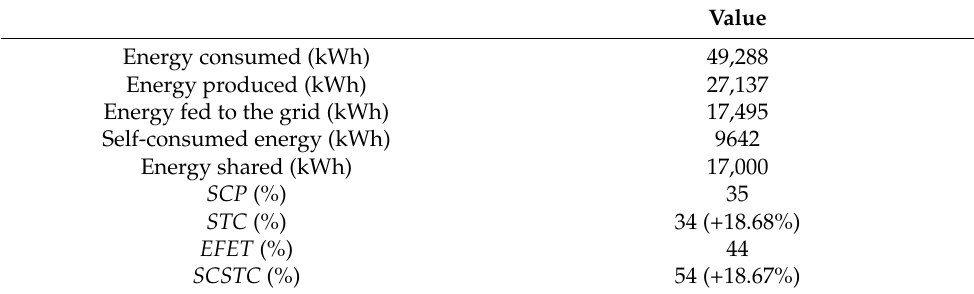
Table 8. Energy statistics and parameters after applying the load-shifting function.